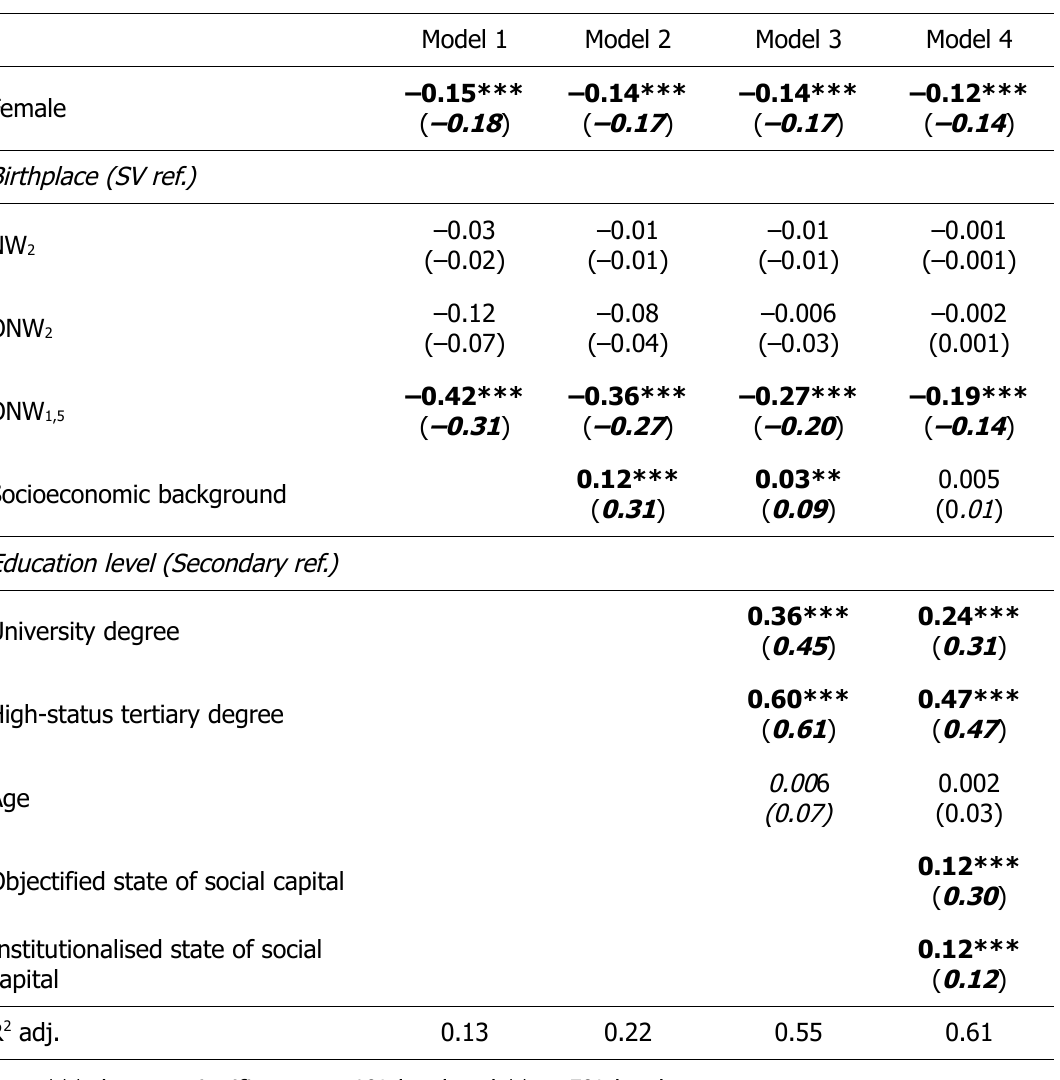
Table 4. Determinants of (LN) monthly salary, OLS regression, partial (and standardized) coeffi- cients, N =